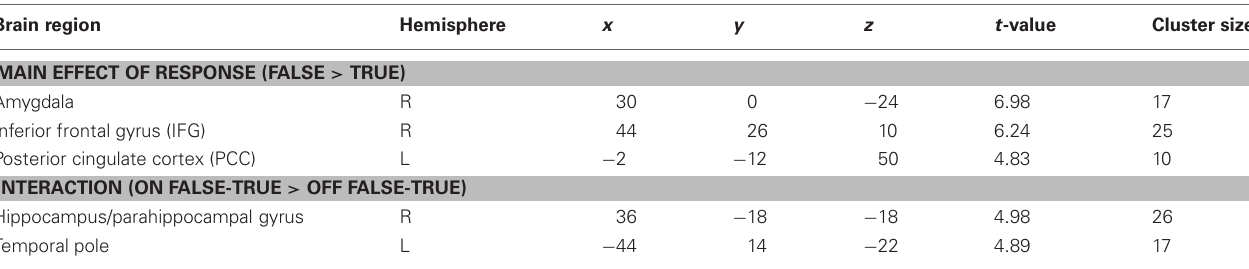
Table 1 | Brain regions showing activation during response production. Brain region Hemisphere MAIN EFFECT OF RESPONSE (FALSE > TRUE) Amygdala Inferior frontal gyrus (IFG) Posterior cingulate cortex (PCC) INTERACTION (ON FALSE-TRUE > OFF FALSE-TRUE) Temporal